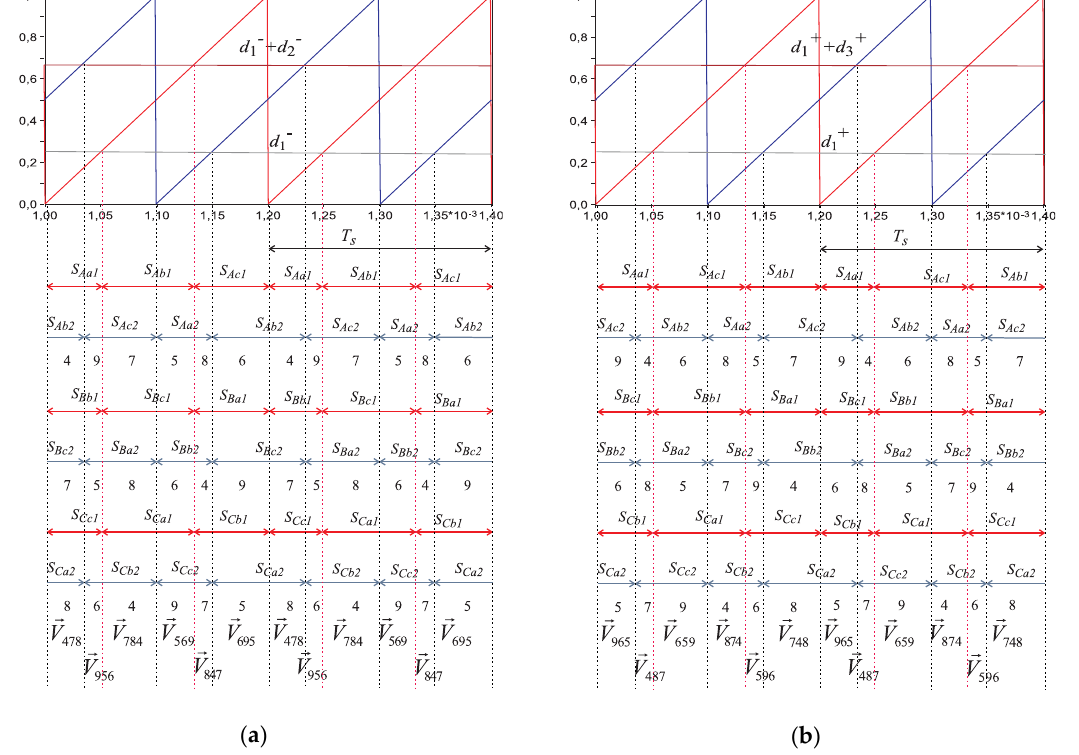
Figure 3. Switch duty cycles and rotating space vectors of the output voltage in MMC for CCW-type space vectors ( a ) and CW-type space vectors ( b ).